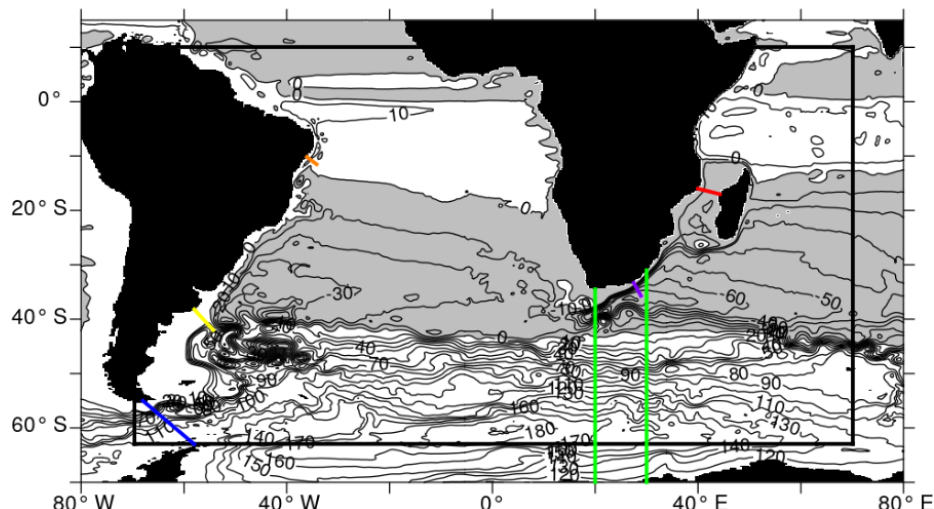
Figure 6. Mean (2000–2009) barotropic stream function as simulated within INALT20 (nested region demarcated by the black box). Grey shading indicates anti-cyclonic circulation; contours are in 10Sv intervals. The band for ACC transport calculations south of Africa is marked by the green lines; the Drake Passage is indicated in blue; the location of the LOCO array is given in red, the section crossing the Malvinas Current in yellow and the section crossing the North Brazil Current in orange. The purple line indicates the location of the ACT array that is referred to in Sect.